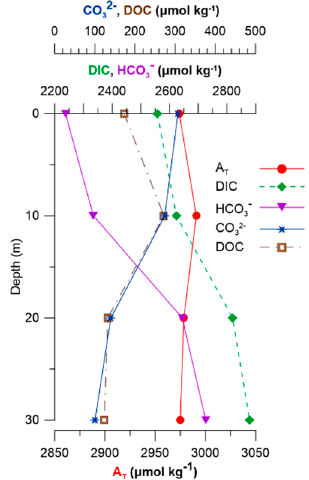
Figure 6. Vertical distribution of carbonate system parameters (A T , DIC, HCO 3 − and CO 32 − ) and DOC (in μ mol kg − 1 ) in Elefsis Bay during field sampling (September 2014).